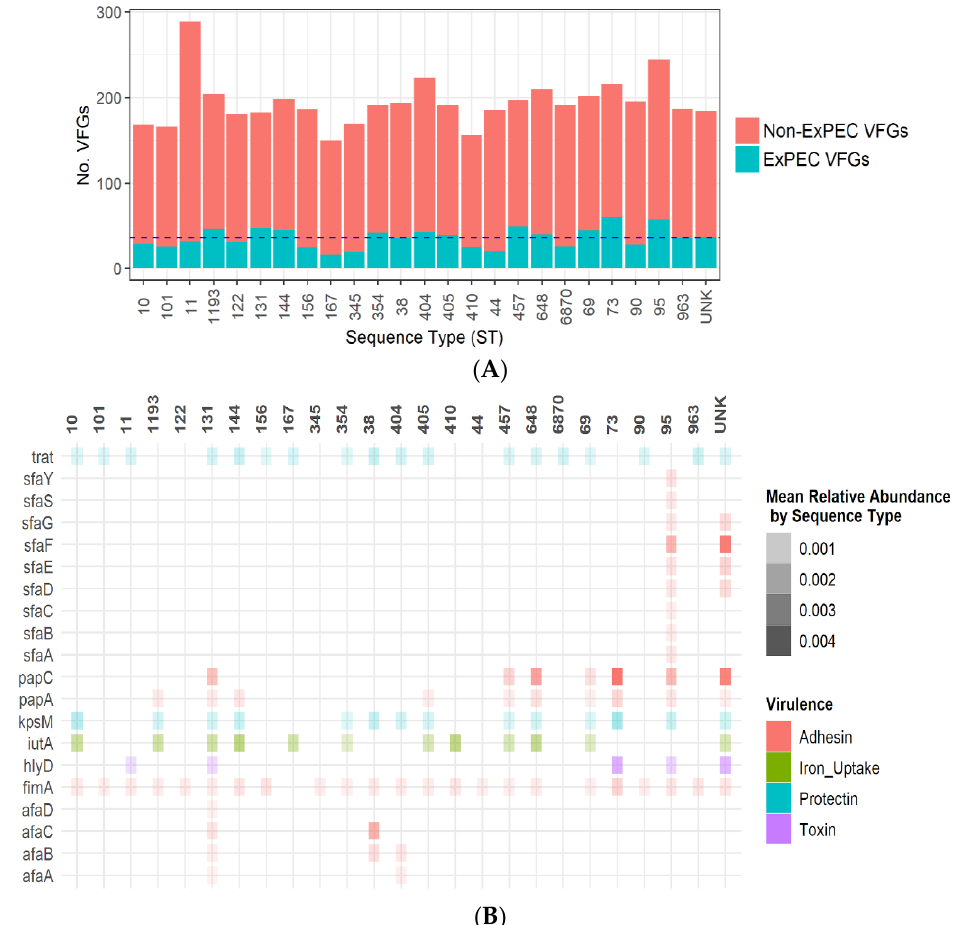
Figure 2. Distribution of putative extraintestinal pathogenic E. coli (ExPEC) virulence factor genes (VFGs) compared to non-ExPEC associated VFGs among E. coli STs from Alameda County, CA hospital patients from 2017–2019. ( A ) Putative ExPEC virulence genes representing 19 sub types from seven virulence gene families ( afa, fim, hlyD, iutA, kpsM, traT, pap, sfa ) were selected for sub-analysis. The average number of ExPEC VFGs among all STs was calculated and displayed as the dashed blue y-intercept line, with a value of 35.68 ExPEC VFGs per ST. ( B ) The relative abundance of each virulence gene is the total length of the virulence gene sequence divided by the total genome sequence length. The mean value of relative abundance was calculated by ST.